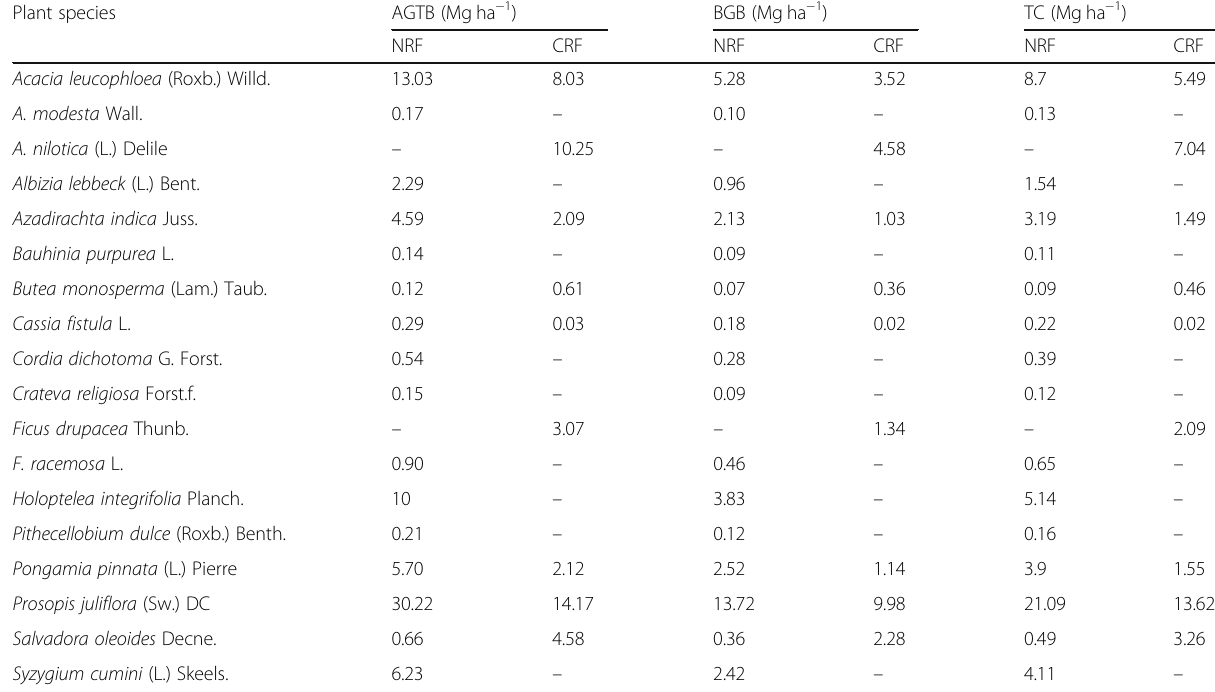
Table 2 Biomass and carbon content in different tree species Plant species